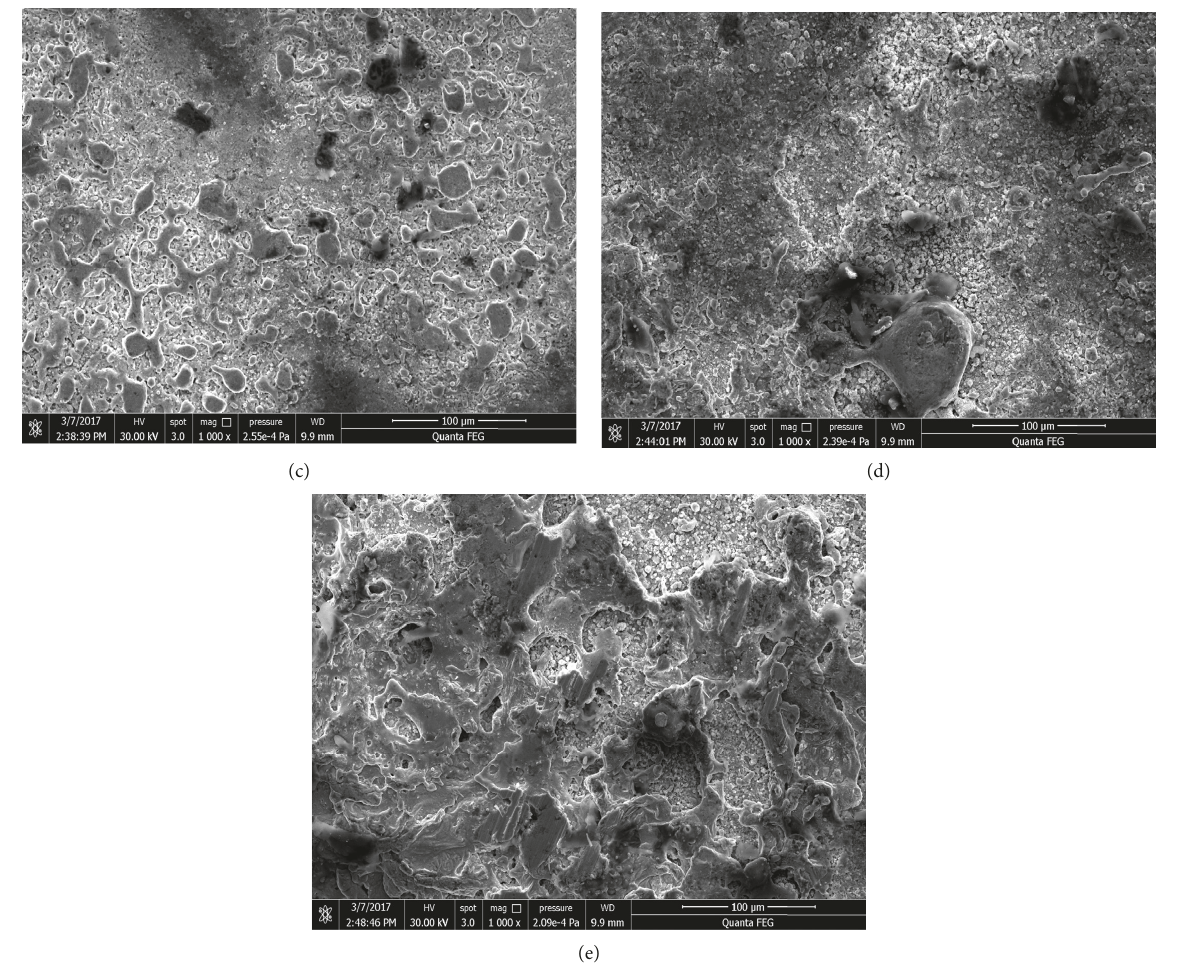
Figure 8: The surface microstructure photos of Ag-SnO 2 /La 2 O 3 contact material with different additive particle sizes: (a) 50nm, (b) 200nm, (c) 500nm, (d) 1000nm, and (e)